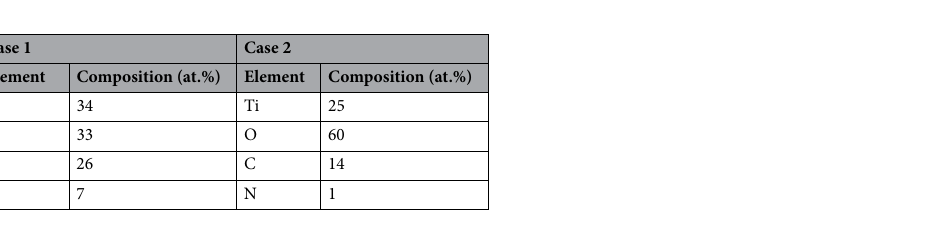
Table 2. Elemental compositions of thin films deposited with case 1 and 2